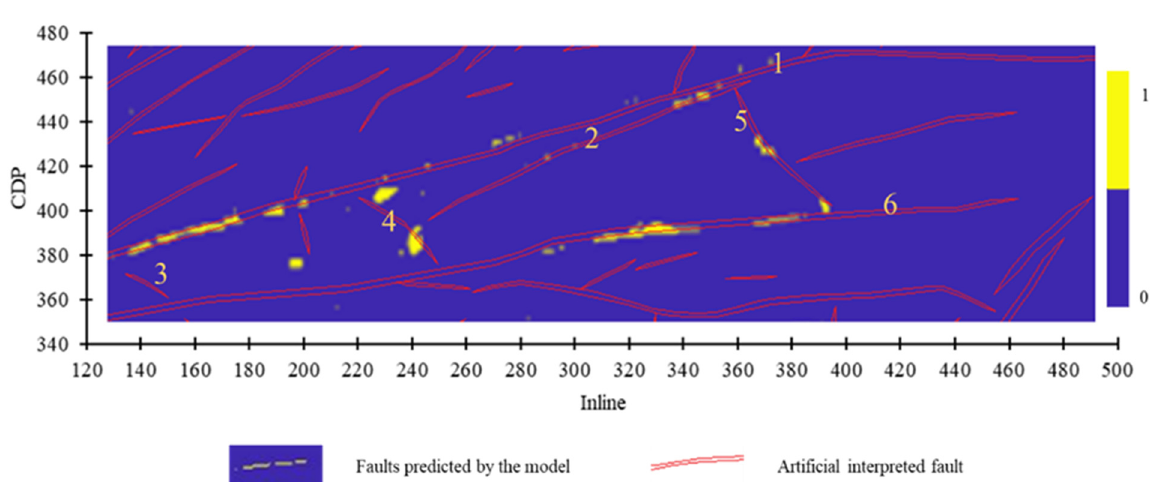
Figure 12. Prediction result of Fault 7 and Fault 8 by Model 2.